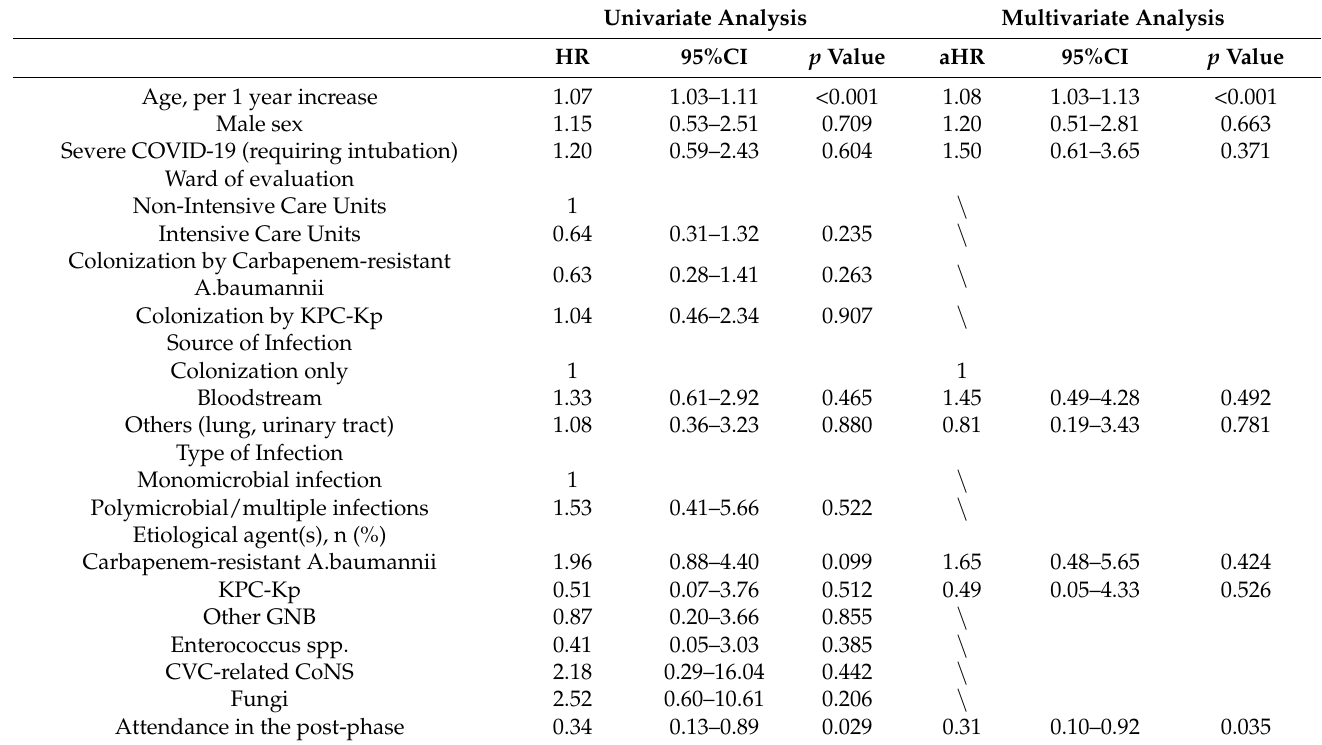
Table 4. Univariate and multivariate Cox regression model for 28-day risk of